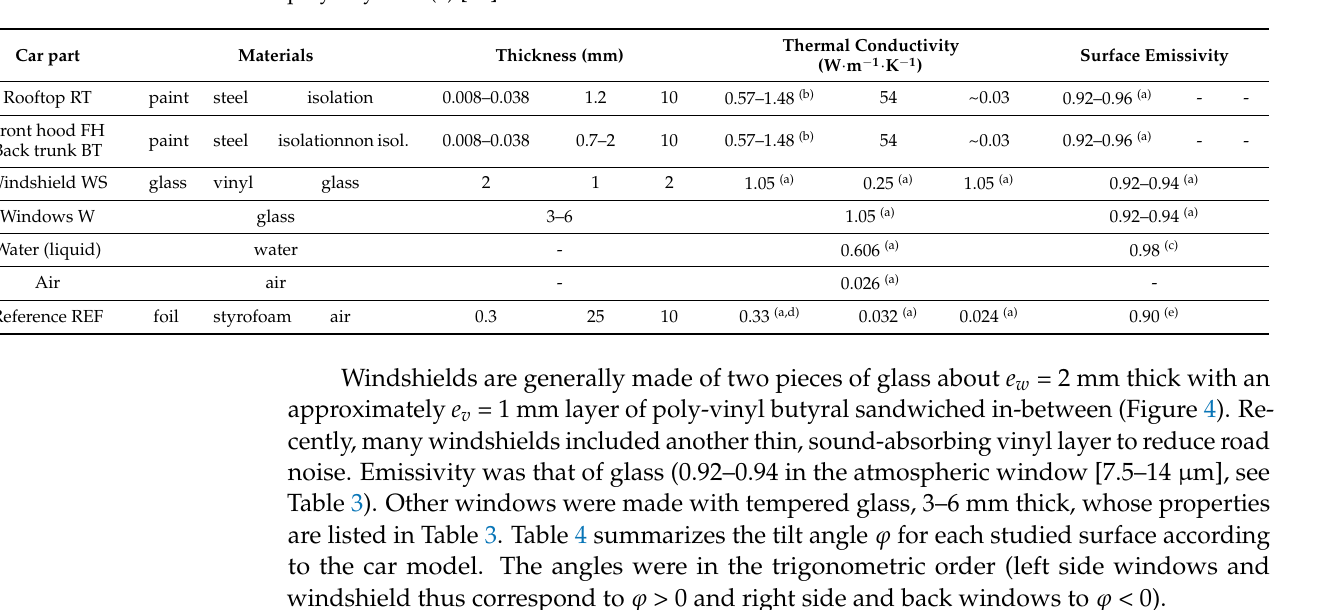
Table 3. Some characteristics of different car surfaces compared to water properties (room tem- perature). (a) [20]. (b) [21]. (c) [22] (in the atmospheric window (7.5–14 µ m)). (d) Low density polyethylene. (e) [17].